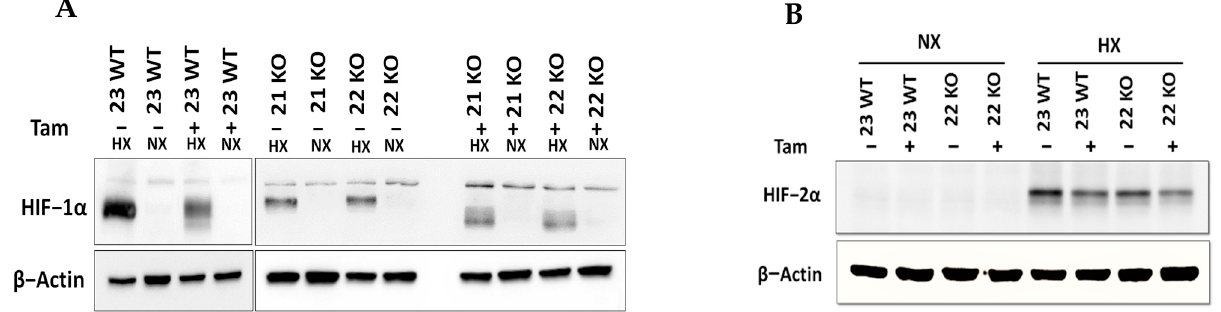
Figure 3. HIF-1 α ( A ) and HIF-2 α ( B ) protein expression in mHDC, as determined by Western blotting. HIF-1 α KO was induced with tamoxifen (Tam). Cells designated “23 WT” were Cre negative, thus Tam did not induce a HIF-1 α KO. The Cre positive cell lines “21 KO” and “22 KO” expressed a shorter non-functional version of HIF-1 α after Tam treatment. The cells were incubated under normoxic (NX) or moderately hypoxic conditions (HX, 1% O 2 ) for 4 h. Beta actin was used to demonstrate equal loading and transfer.